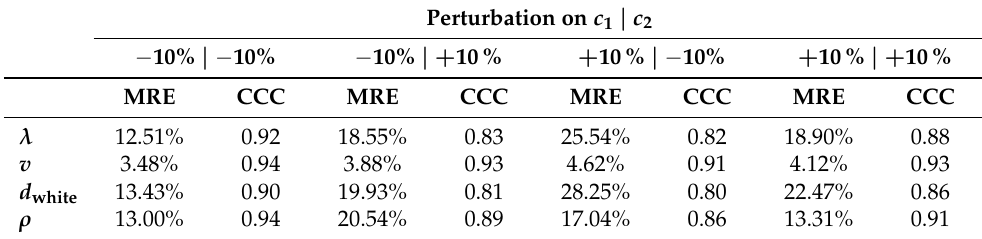
Table 4. Median relative errors (MRE) and Lin’s concordance correlation coefficients (CCC) [47] between the true and predicted values of λ and v provided by the second network (Figure 6) and of d white and ρ derived using Equations (12) and (13), computed over the test set for all combinations of ± 10% perturbations on the c 1 and c 2 threshold values used to generate the input contours Γ 1 , Γ 2 , and Γ 3